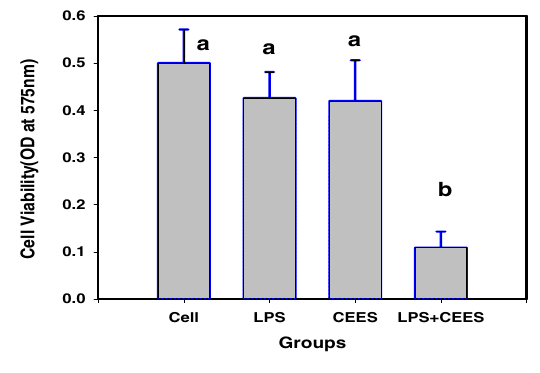
Figure 1 LPS (100 ng/ml) enhances the cytotoxicity of CEES (500 µ M). Means not sharing a common letter are significantly different (p < 0.05). Cytotoxicity was measured, after 24 hours, by the MTT assay described in the